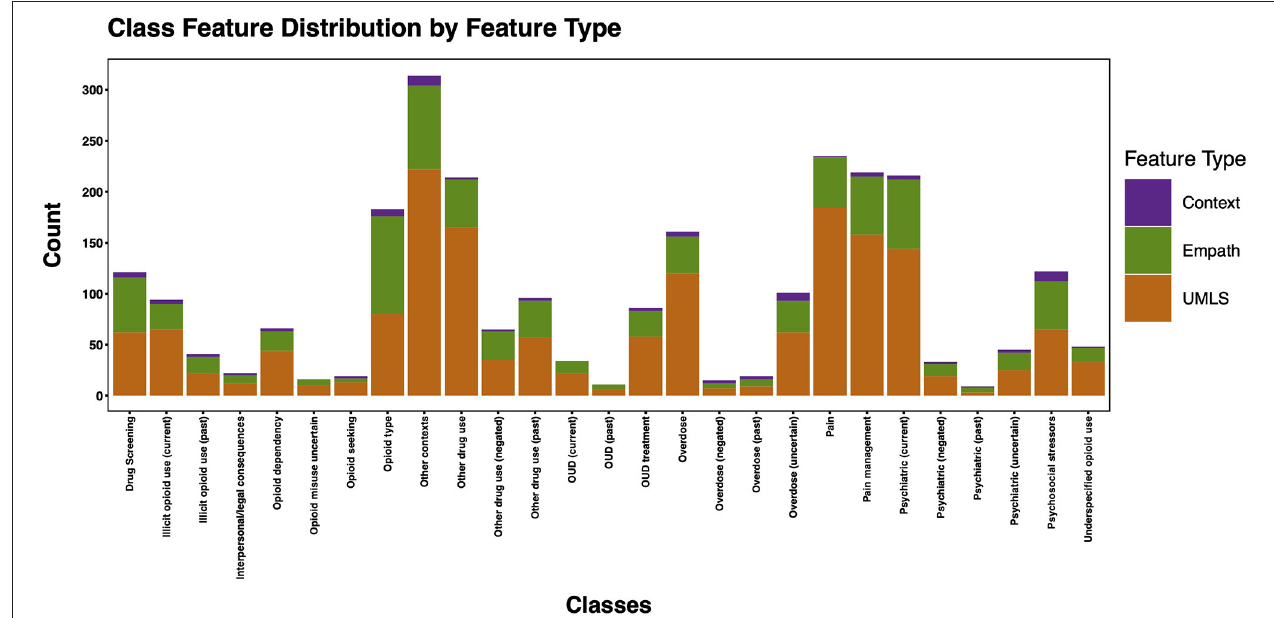
FIGURE 10 | Histogram of total features per class post-feature selection by feature